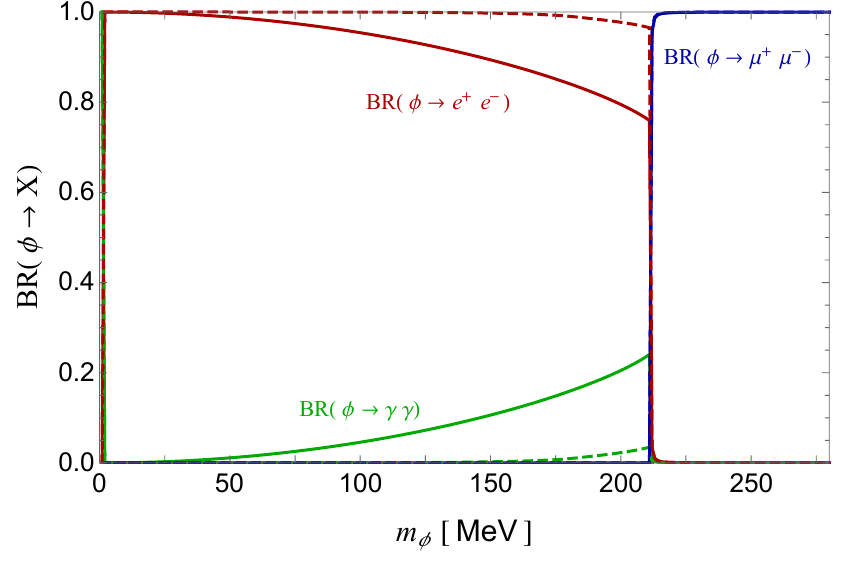
Figure 2 . Branching ratios of the allowed (cid:30) decay modes. The solid lines show branching ratios BR( (cid:30) ! X ) when the coupling (cid:15) ‘ (cid:24) 1 is (cid:12)xed to (cid:12)t the central value for (cid:1) a (cid:22) , and (cid:15) q = (cid:15) W (cid:24) 6 (cid:2) 10 (cid:0) 3 is (cid:12)xed so that BR( K L ! (cid:25) 0 (cid:30) ) = 10 (cid:0) 6 . In dashed lines, the branching ratios for singlet scalar mixing model (cid:15) q = (cid:15) W = (cid:15) ‘ are shown. In the latter case, a dramatic cancellation between W loop function and fermion loop function happens for m (cid:30) around the pion mass, which leads to a higher electron-positron decay branching ratio even with a much smaller (cid:15) ‘